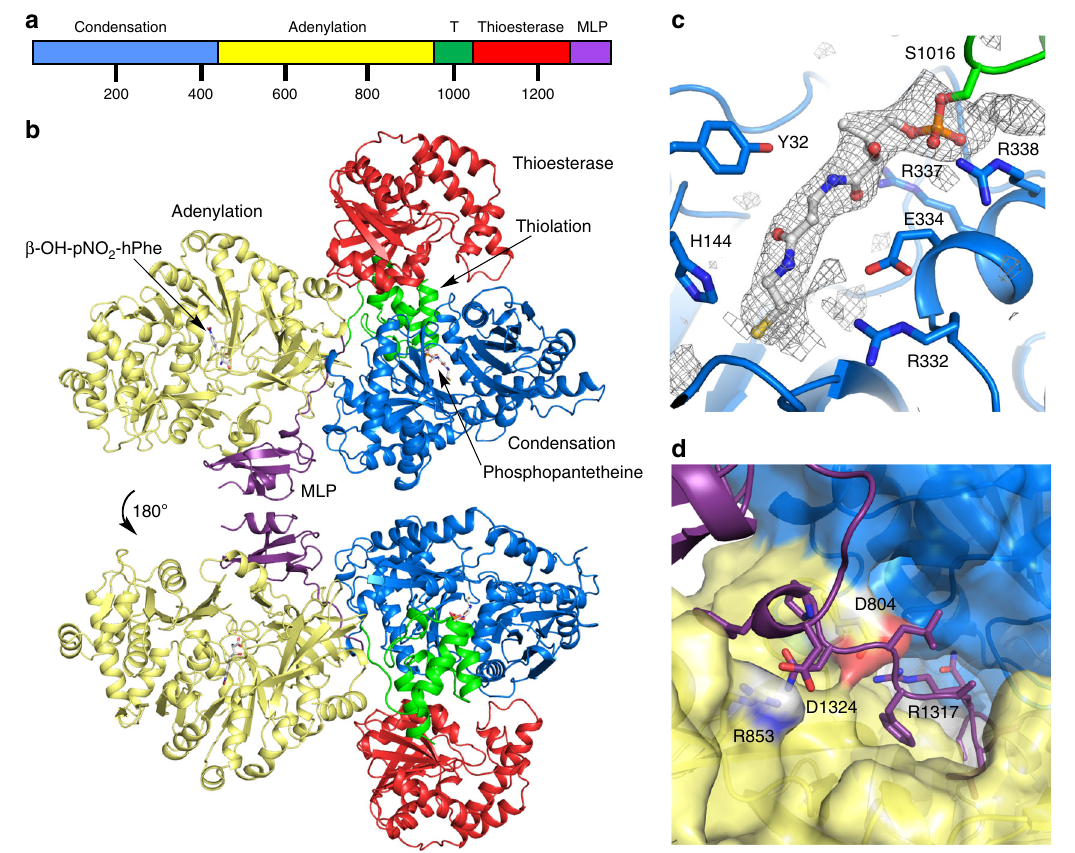
Fig. 2 Structure of the BD-ObiF1 module. a ObiF1 from Burkholderia diffusa possesses a C-A-PCP-TE-MLP domain architecture. b Front and back side view of the holo-ObiF1 module. c The pPant arm is positioned in the C domain near the canonical catalytic C domain His residue (His144). Electron density (contoured at 3.0 σ ) calculated with mF o – DF c coef fi cients from an omit map (ligand occupancy set at zero) generated with simulated annealing. d A surface representation of the A and C domain interface illustrates the salt-bridging interactions that occur between the N-terminal region of the MLP domain